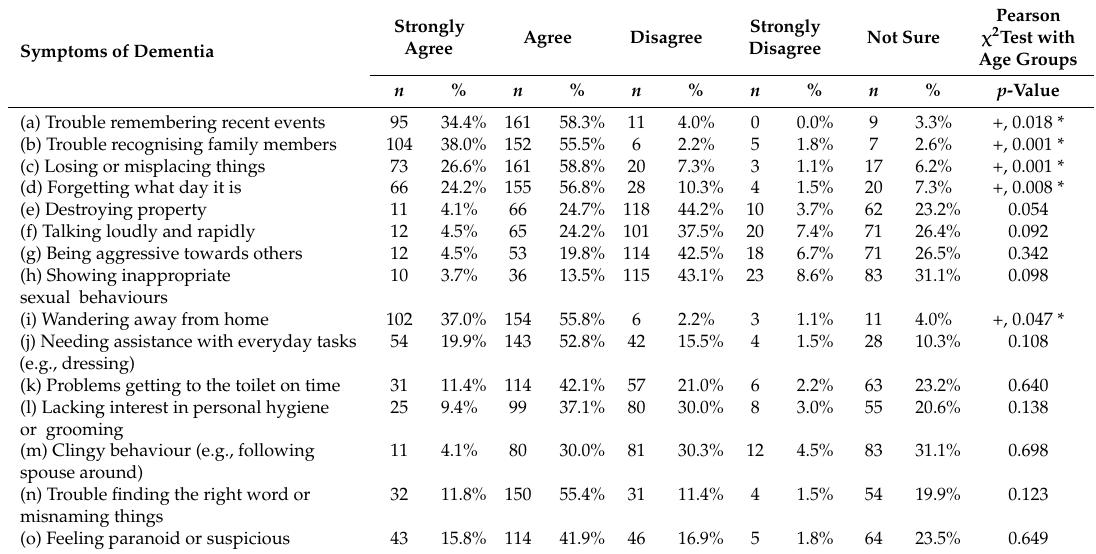
Table 5. Views on the symptoms of